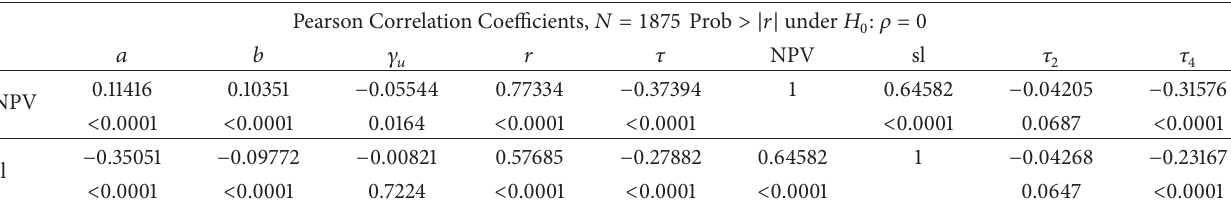
Table 2: The correlation test with test parameters and decision variables.